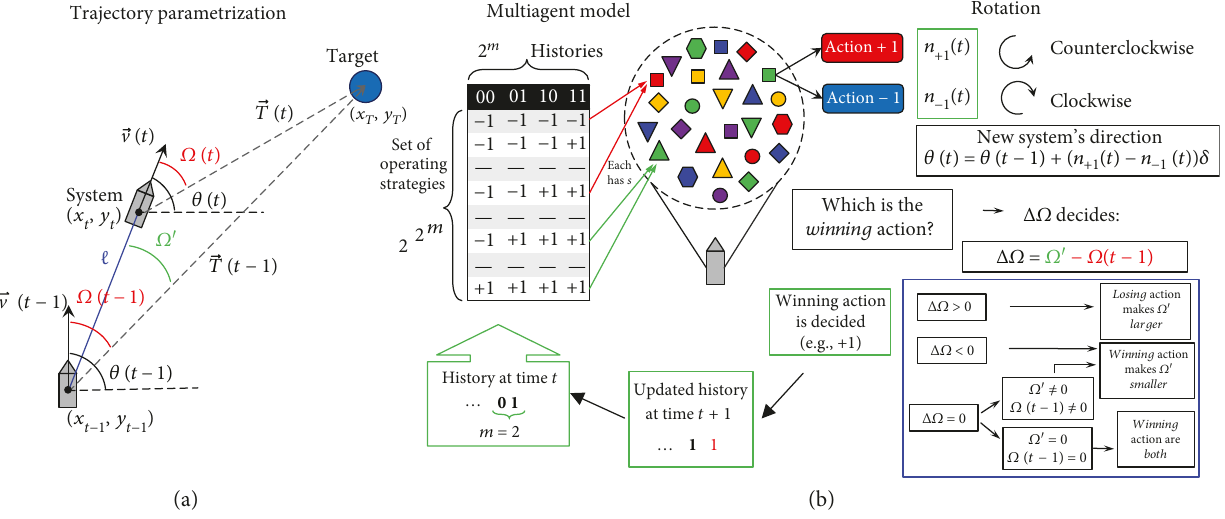
Figure 1: (a) Parametrization of the trajectory of a moving system advancing towards a well-de fi ned target. The velocity vector v makes an angle θ with the horizontal and an angle Ω with the vector T which points from the system to the target. Ω ′ is de fi ned as the angle between the vector velocity v t at time t , and the target vector T t − 1 at time t − 1 . (b) Our nonlinear model of klinotaxis. N heterogeneous adaptive agents holding s strategies each, decide on a speci fi c action using their respective highest scoring strategy from among the s that they possess. These are assigned randomly to each agent at the start of the simulation, from the full strategy space to mimic agent (i.e., component) heterogeneity across the N agents. The aggregate of their autonomous actions contributes to the rotation of the moving system either clockwise or anticlockwise by an angle δ . The winning option is decided from the resultant angle Δ Ω as shown. Subsequently, the winning history is updated, announced, and used by each agent as a new input to decide on its next action. Dashes in the list of strategies are used to indicate groups of strategies that, for clarity, are not explicitly written